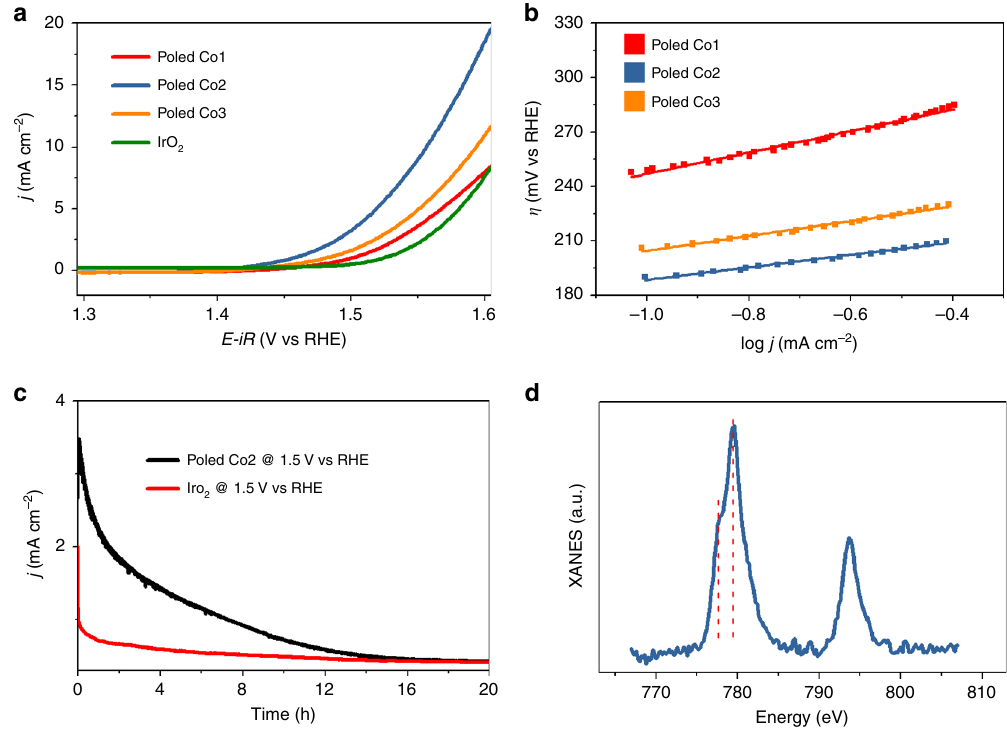
Fig. 6 Electrocatalytic characterization for the corona-poled samples. a LSV curves at the scan rate of 5 mV s − 1 ; b Tafel plots; c long-term chronoamperometric measurement of poled Co2 and IrO 2 ; d Co L -edge XAS spectra of the poled Co2 sample before chronoamperometric